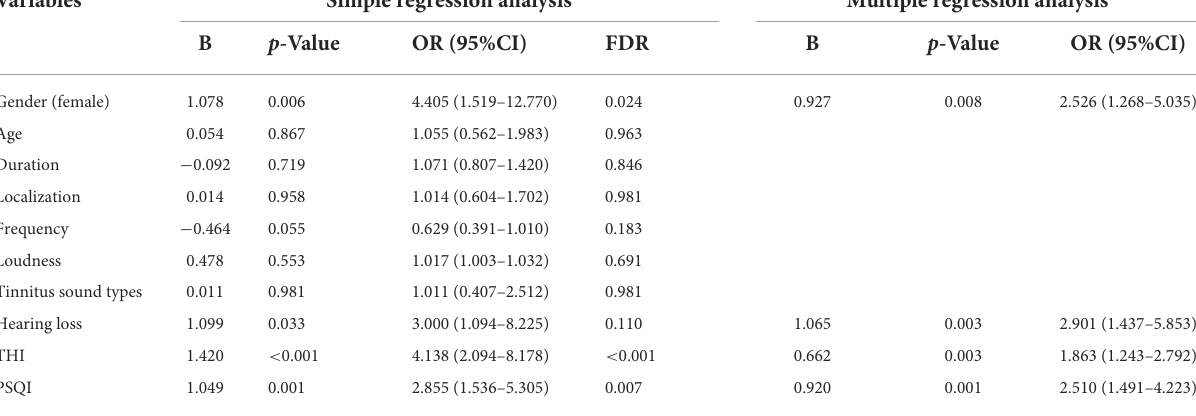
TABLE 4 Logistic regression results for risk factors associated with